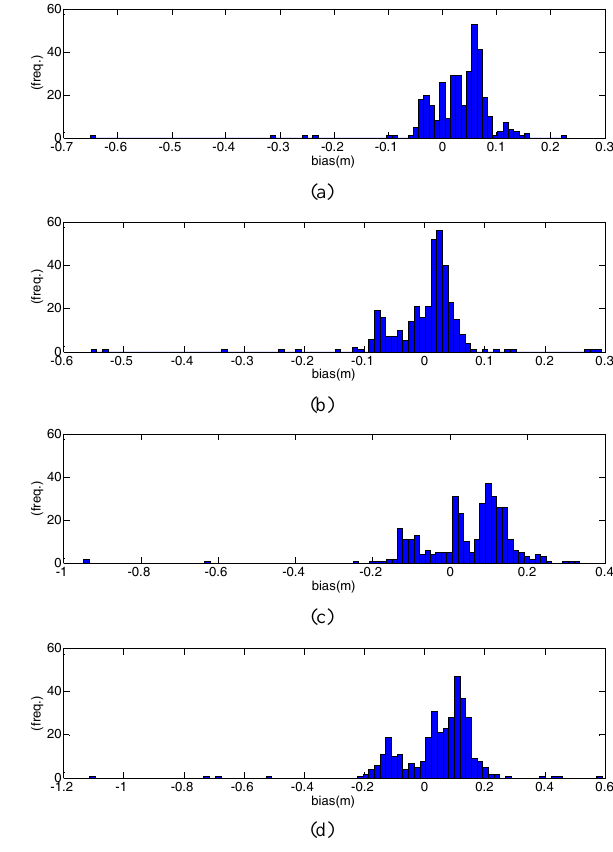
Figure 7 The error distribution of RNN outputs in testing phase for (a) 5-, (b) 10-, (c) 15-, and (d) 20-min-ahead